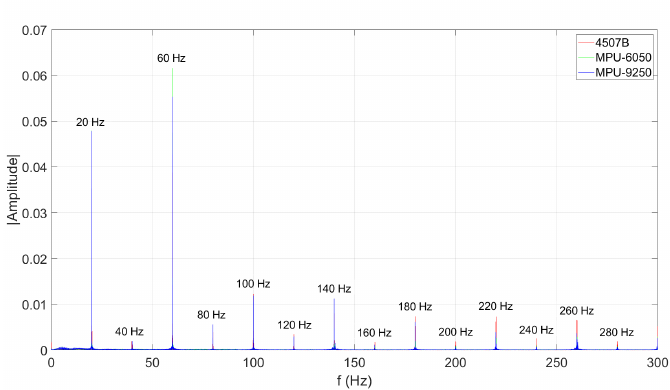
Figure 9. Responses in the frequency domain using the modulated shaker at 20 Hz/0,2g.